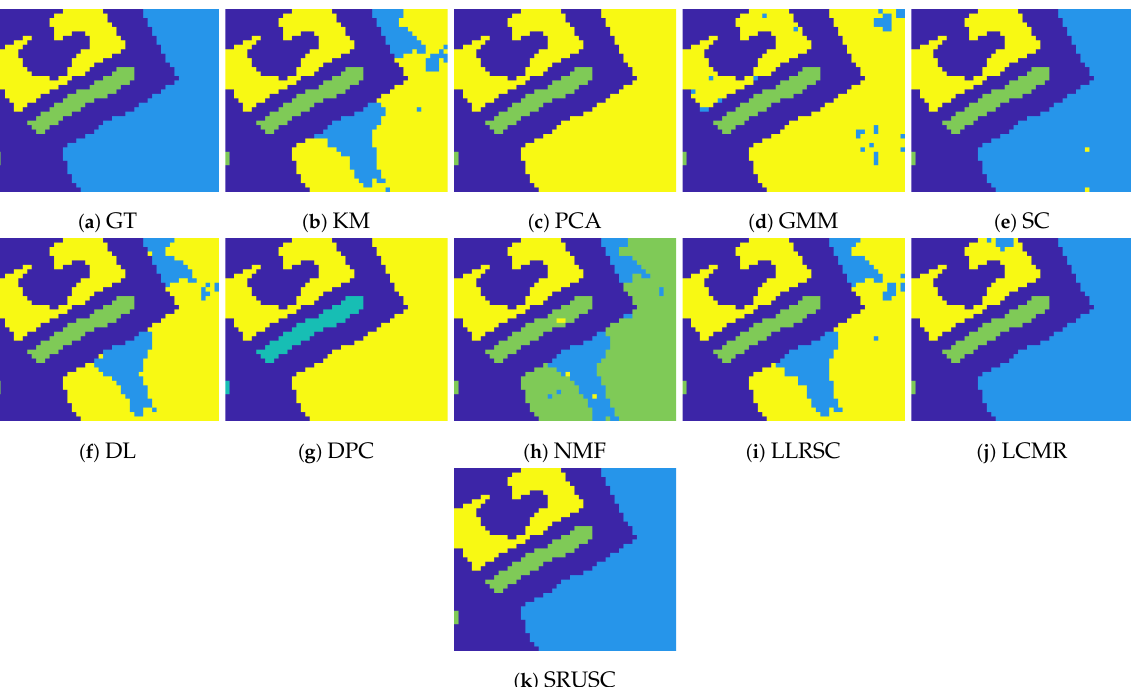
Figure 10. On the Salinas A data set, the proposed method performs strongly, with DL also performing well. Note that SRUSC nearly correctly estimates the number of clusters. As shown in Figure 12, it estimates 7 clusters rather than 6. This strong estimation is an additional advantage of SRUSC for the Salinas A dataset.